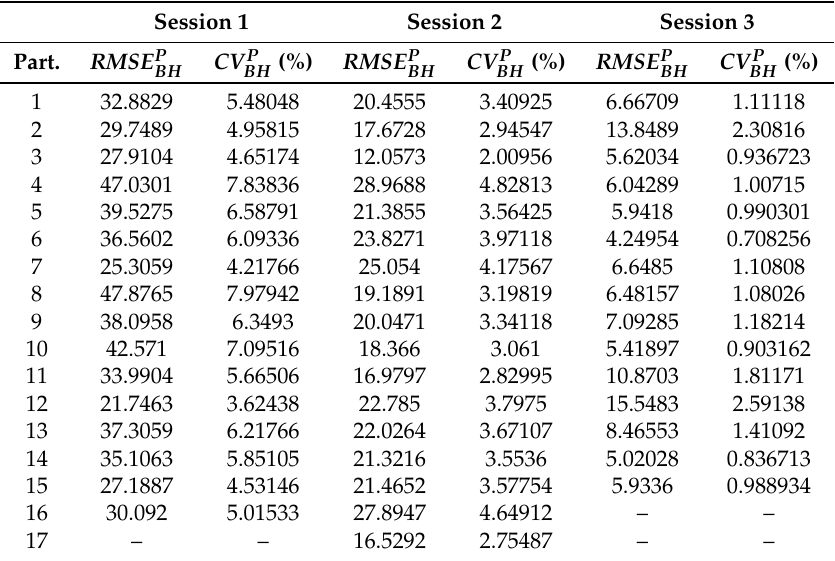
Table 8. Forecast errors of the Brock and Homme model ( BH ) for the three sessions. Session